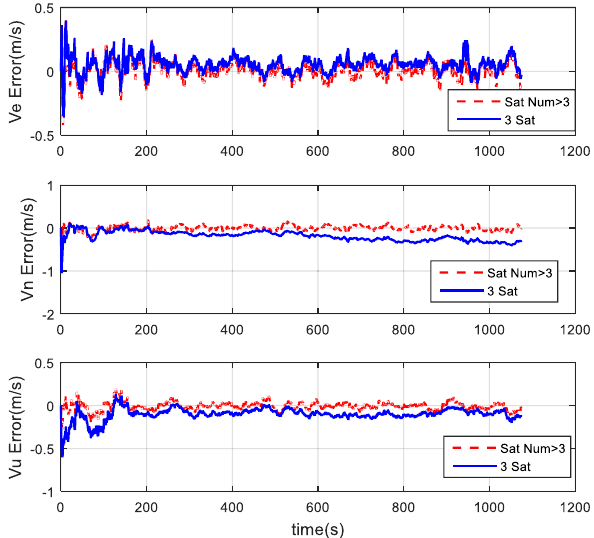
Figure 19. Velocity comparison of navigation by normal number of satellites and 3 satellites.